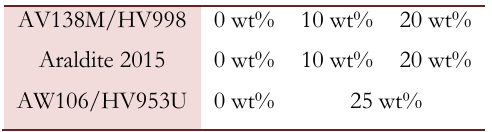
Table 3: Mass fractions studied for the three